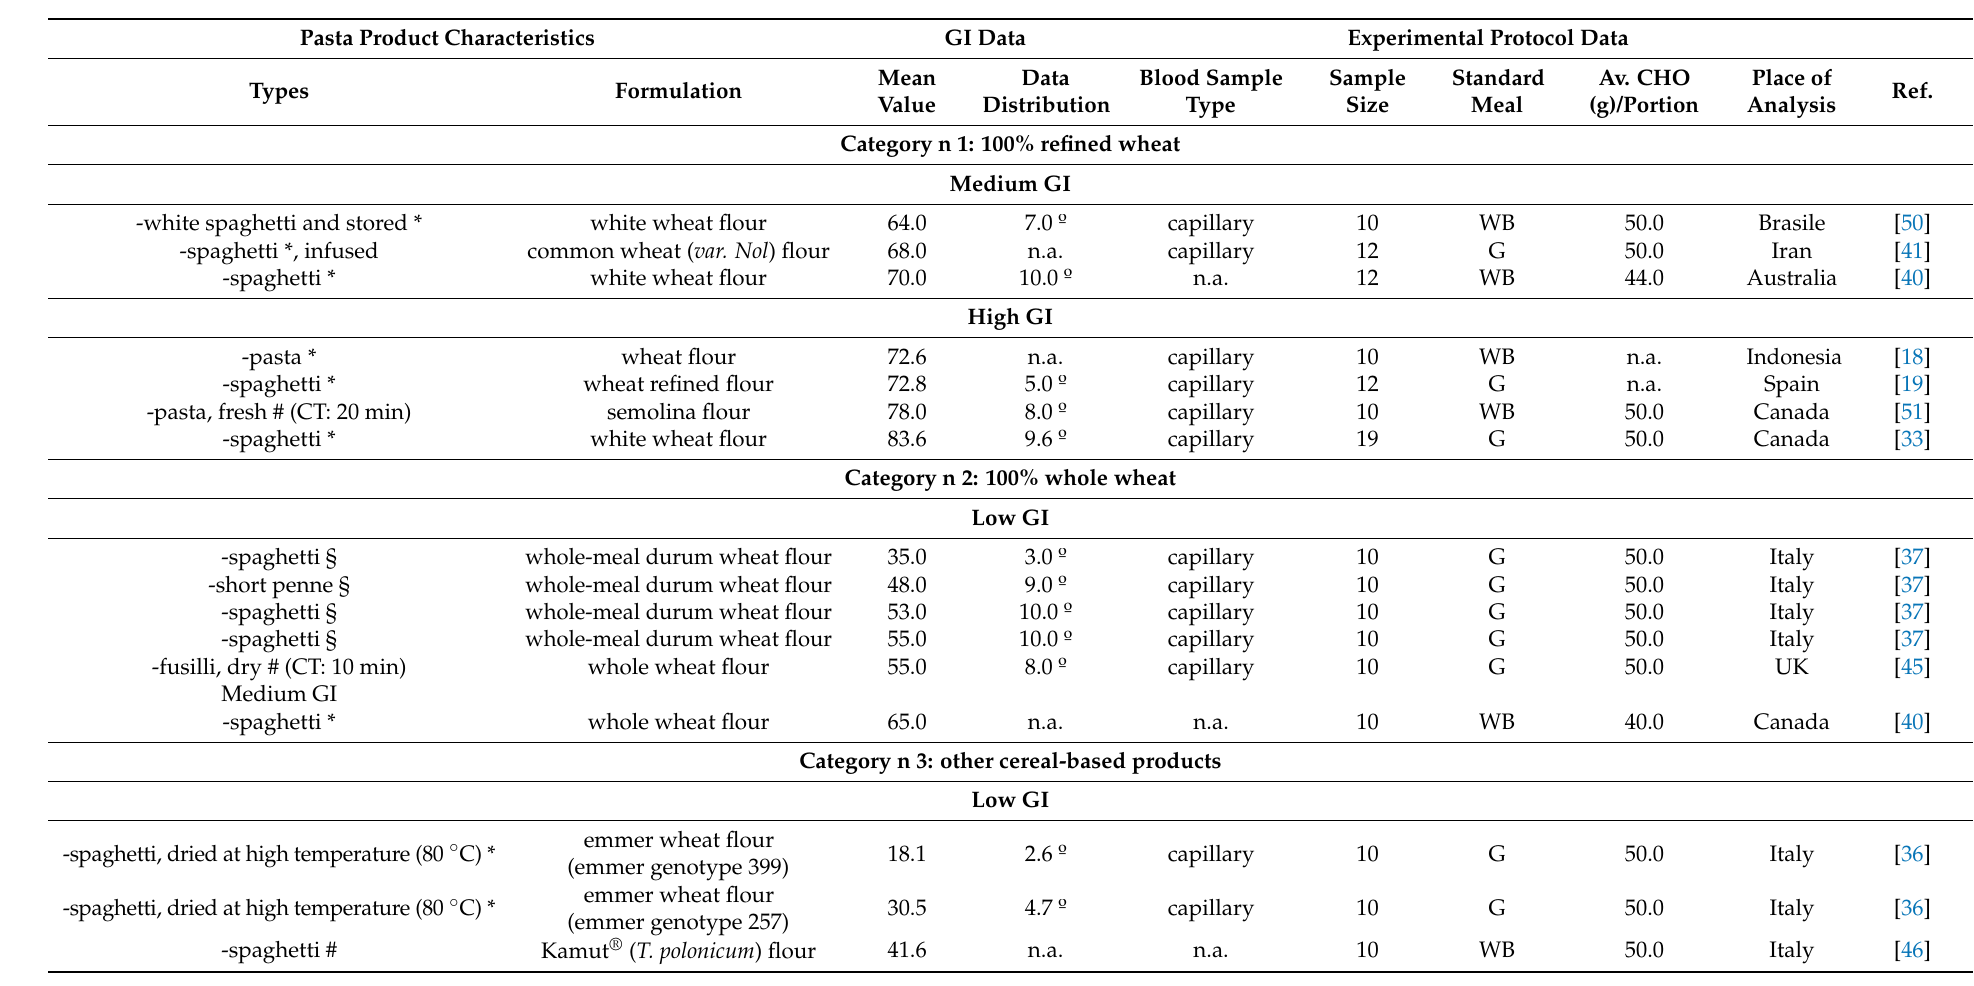
Table 1. Pasta product characteristics, glycemic index and experimental protocol data.